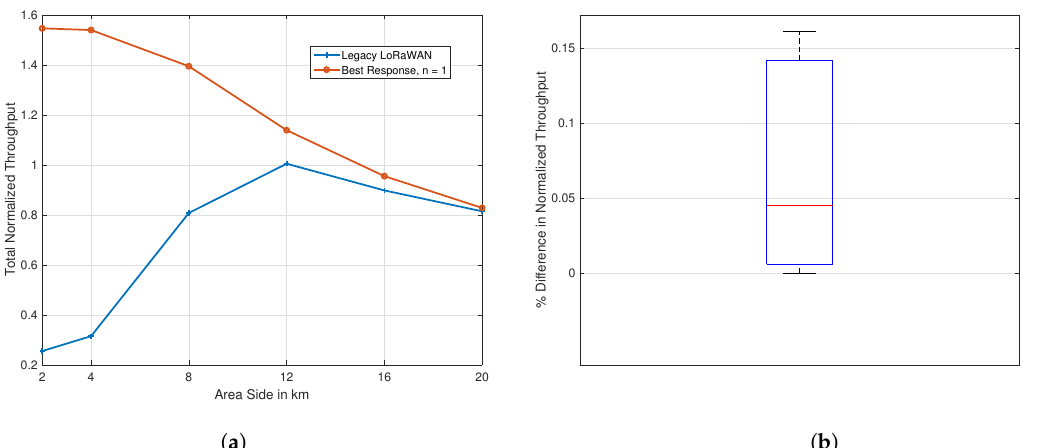
Figure 4. Impact of the area size on the performance. ( a ) Game approach gains. ( b ) Best response vs. learning approach.